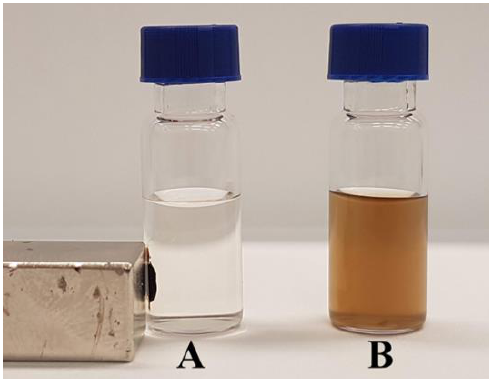
Figure 9. MNP added to solutions of tetracyclines: in a magnetic field ( A ) and suspended in the solution ( B ).